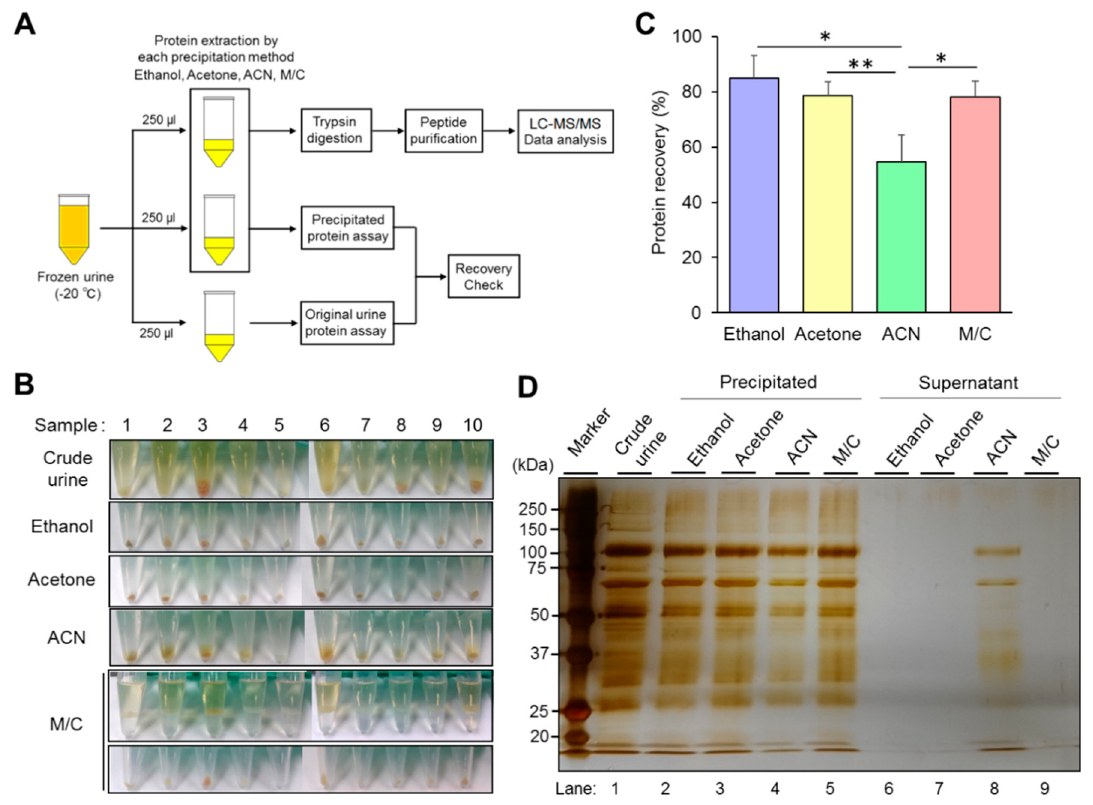
Figure 1. Characterization of each precipitation method. ( A ) The design of study for the characterization and evaluation of the performance in each precipitation. Crude urine was stored at –20 ◦ C, then thawed at 37 ◦ C before use. The 250 µ L aliquots of urine samples were used for the investigation of precipitated urine protein recovery rate and protein identification, respectively. ( B ) The condition of precipitated urine protein in each precipitation method. The pictures indicate the condition of final precipitated urine proteins prepared by ethanol, acetone, acetonitrile (ACN), and methanol / chloroform (M / C) precipitation. Only for M / C precipitation method, the pictures indicated the condition both after initial centrifugation and final precipitated proteins. ( C ) The recovery rate of precipitated urine protein in each method. The urine protein concentrations in crude and precipitated samples were measured by Bradford protein assay. The recovery rate of precipitated protein was calculated by following the formula indicated in materials and methods in Section 2.4. ( D ) Silver staining image of the proteins in precipitated and in supernatant prepared by each precipitation. The proteins in those samples were separated by SDS-PAGE and were visualized by silver staining. The total protein amount loaded on the gel was adjusted with an identical amount originated from 20 µ L of crude urine. ( B , C ) The data are based on 10 urine samples originated from di ff erent health volunteers. ( D ) The data is representative of at least three independent experiments. The Student’s t -test was used to analyze data for significant di ff erences. Values of * p < 0.05, ** p < 0.01 were regarded as significant.